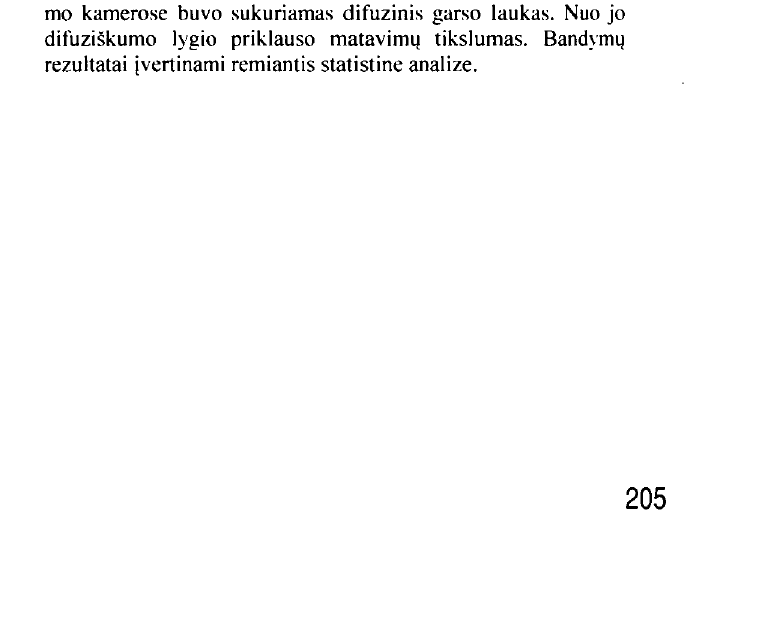
rezultatai jvertinami remiantis statistine